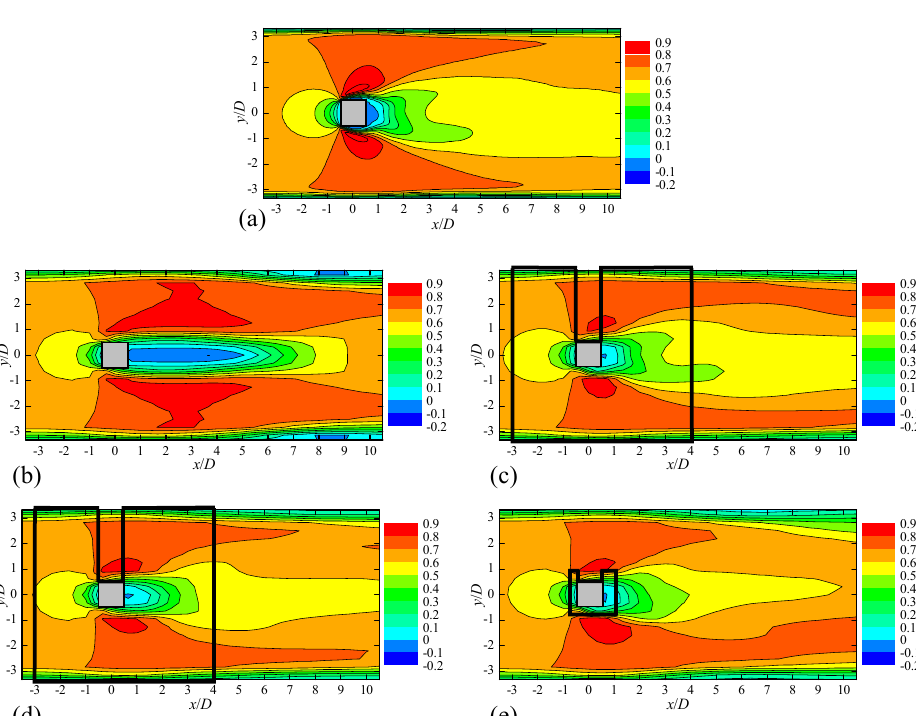
Fig. 4 Comparison of mean velocity u (c) PIV-MI simulation with full feedback ( A simulation with temporally limited feedback ( A simulation with spatially limited feedback ( A